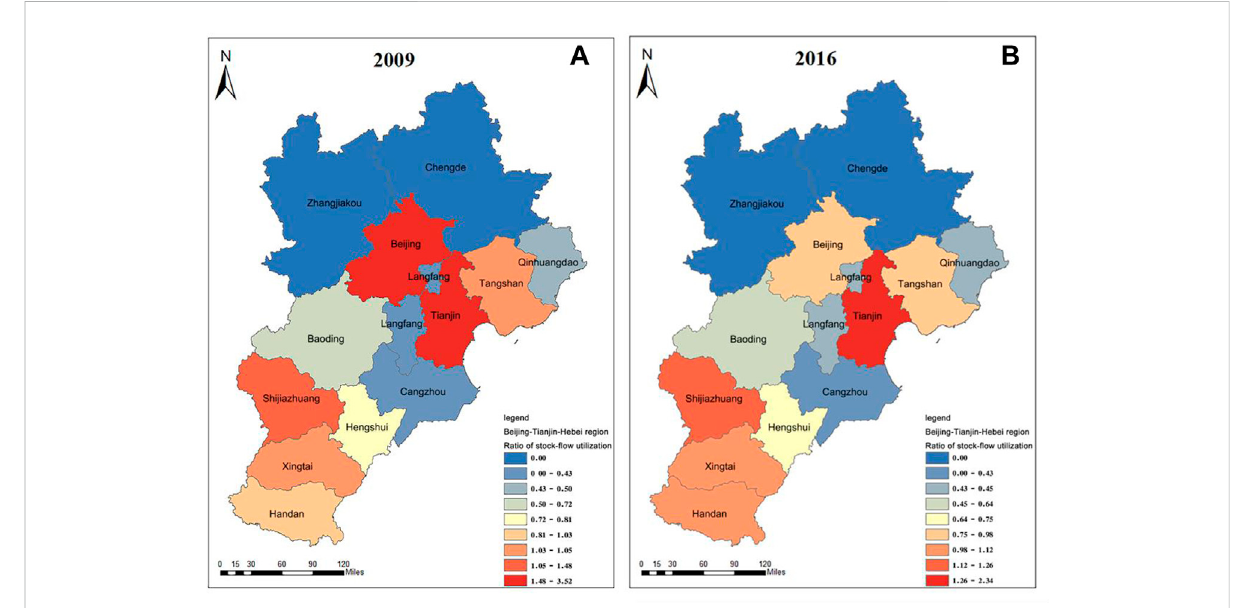
FIGURE 7 Stock- fl ow utilization ratio of cultivated land natural capital in the Beijing-Tianjin-Hebei